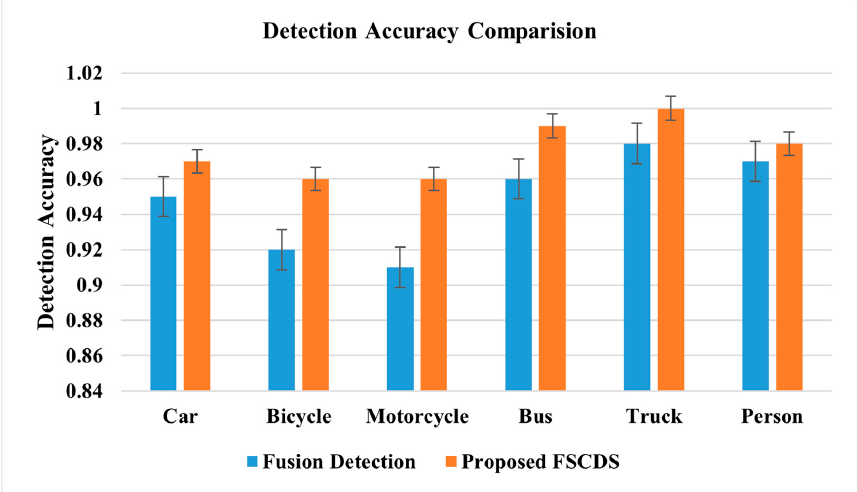
Figure 17. Detection accuracy comparison of fusion detection and FSCDS.